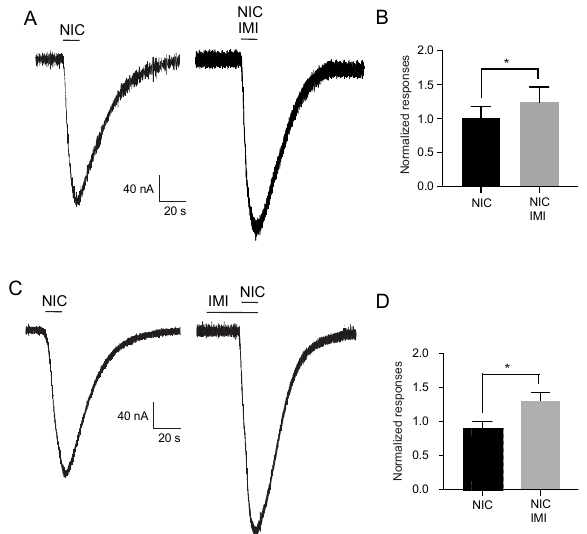
Figure 3. Effect of co-application and pretreatment of IMI on nicotine-evoked current amplitudes. ( A ) Currents induced by 10 mM nicotine (NIC) and the co-application of both 10 µM imidacloprid and 10 mM nicotine. ( B ) Histograms illustrating co-application of 10 µM imidacloprid (IMI) with 10 mM nicotine. ( C , D ) currents and histograms under 10 mM nicotine and 5 min pretreatment with 10 µM imidacloprid (IMI). Data are mean ± SEM. * p < 0.05. Each histogram represents n = 12. The co-application of 10 µM THI with 10 mM nicotine significantly decreased nico- tine-induced current amplitudes to 54% of the control currents when they were co-applied ( p < 0.05, n = 6, Figure 4A,B), or 28% after 5 min pretreatment ( p < 0.05, n = 6, Figure 4C,D) with 10 µM THI. These results confirm that the two neonicotinoids could be divided into two subgroups having distinct effects on the Pame α 7 receptor.